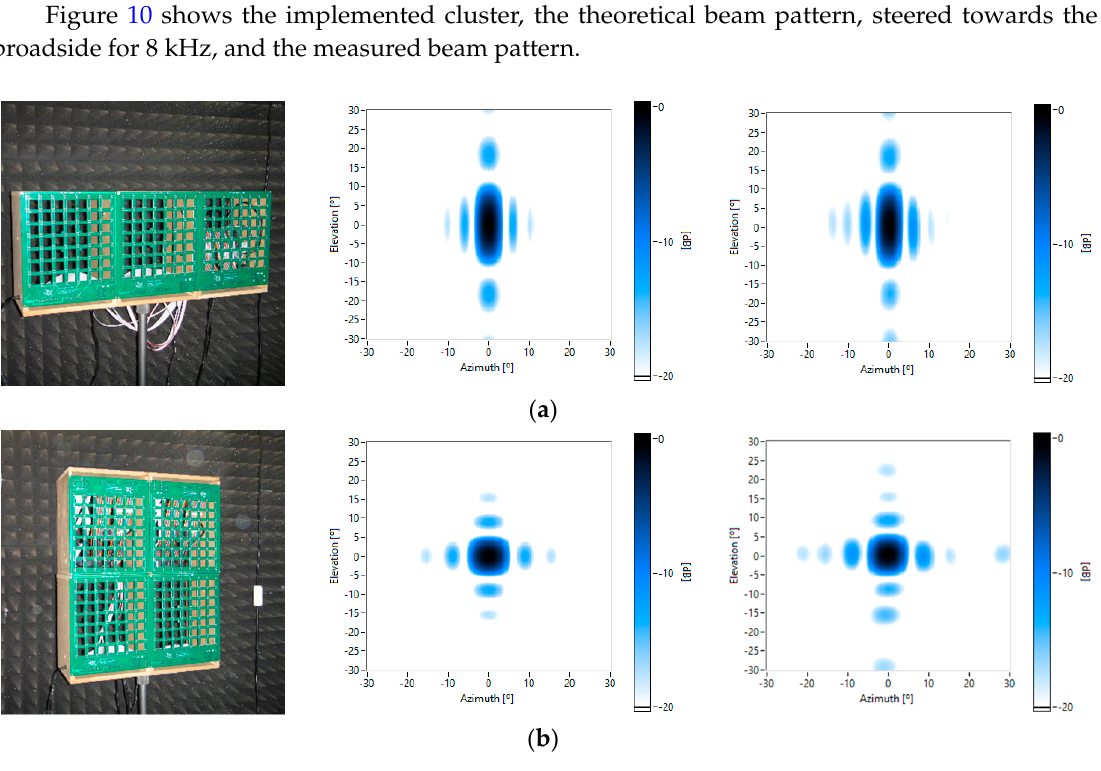
Figure 9. Measured beam patterns for different frequencies and pointing to different steering angles [azimuth, elevation]: ( a ) 4 kHz and [ − 15°, − 15°]; ( b ) 8 kHz and [0°, 0°]; and ( c ) 16 kHz and [5°, 10°].